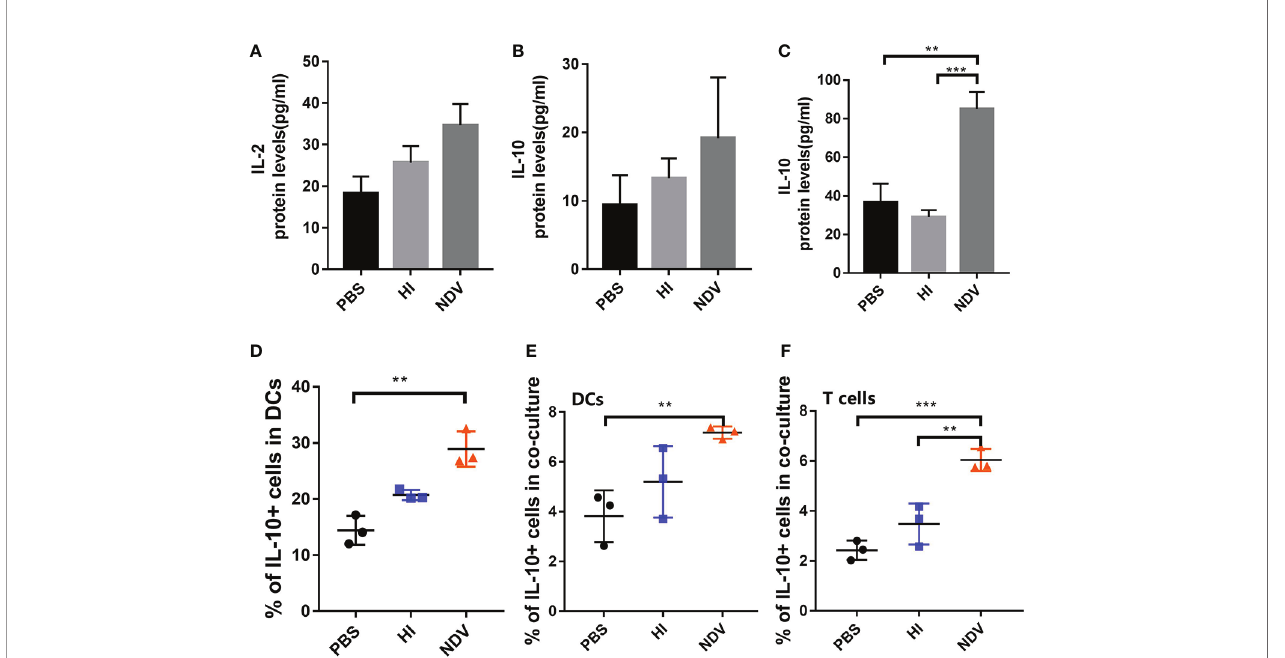
FIGURE 4 | Effect of NDV infection on differentiation of T cells. Supernatants of co-cultures were harvested to measure the secretion of IL-2 (A) and IL-10 (B) by ELISA. Supernatants of pretreated DCs were collected to measure the secretion of IL-10 (C) . Populations of IL-10 expressing DCs were detected using fl ow cytometry (D) . Proportions of IL-10 + DCs (E) and T cells (F) in co-cultures were measured. All experiments were performed independently at least thrice and results were presented as means ± standard deviation. Signi fi cance levels were de fi ned as **p < 0.01 and ***p <